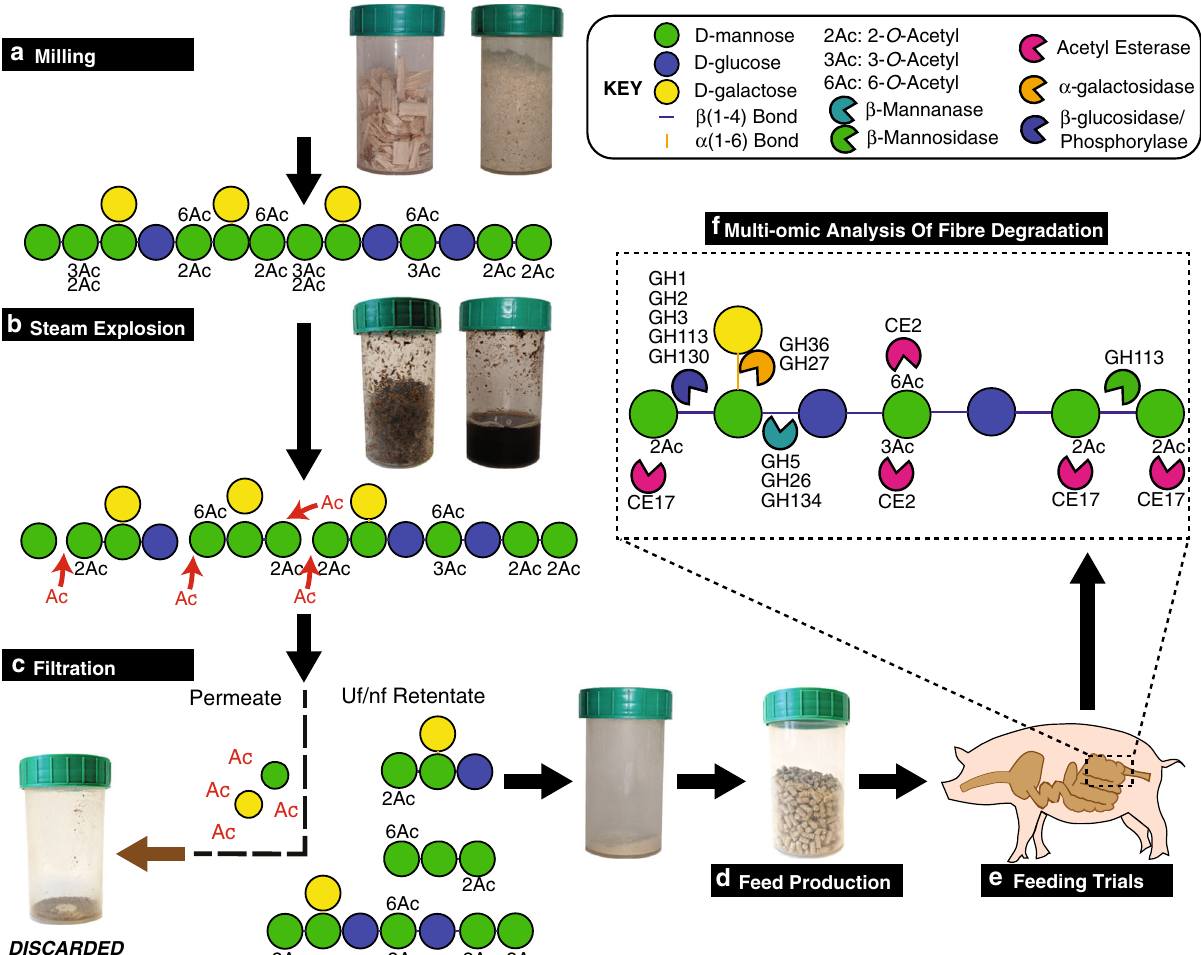
Fig. 1 Schematic representation and graphic illustration of the production pipeline for Norway spruce AcGGM. a Wood chips were milled to increase the surface area exposed for hydrothermal extraction and washing the released manno-oligosaccharides. Spruce wood contains long-chained galactoglucomannan (DP200-400), which is highly acetylated (DA ~ 0.65), predominantly with 2- O and 3- O acetylations 66 . b During hydrothermal pretreatment, the release of acetic acid promoted hydrolysis of glycosidic bonds, thereby relinquishing monosaccharides, oligosaccharides, and other breakdown products. c Ultra fi ltration retained the longer, complex oligosaccharides and discarded the monosaccharides, acetic acid, and other steam explosion byproducts. d The puri fi ed mannan was incorporated into feed pellets at varying inclusion levels, produced by a conventional feed pelleting process. e The growth performance experiment and a feeding trial were conducted in a randomized block design, with four inclusion levels of AcGGM. f Multi-omic approaches were used to analyze the porcine gut microbiome in response to AcGGM and determine if indigenous mannan PULs matched the glycan structure of the AcGGM fi ber. Glycosidic bonds between the β -(1,4)-mannose and glucose units in the backbone of AcGGM require hydrolysis by glycoside hydrolases (GH) from families GH5 and GH26. GH36 and GH27 α -galactosidases are required to remove the α -(1,6)-galactose decorations. Single mannose and glucose units are removed from the non-reducing end of the oligosaccharides by enzymes from families GH1, GH2, GH3, GH113, and GH130, while mannose in the reducing end can be removed by GH113 family mannosidases. 3- O - and 6- O -acetylations on mannan are removed by esterases from family CE2. A unique feature of particular beta-mannans is the axially oriented 2- O -acetylation on mannose, which is the prevalent form of acetylation present on AcGGM used in this study. 2- O -acetylations are removed by esterases homologous to the RiCE17 mannan-speci fi c esterase from Roseburia intestinalis , which was recently characterized by our group 5 We chose a dietary supplementation strategy, which is commonly applied to piglets during the post-weaning period to offset their particularly low feed intake and enhance gut health and growth performance 19 . Cautious measures were made to eliminate potential pen biases (see details in materials and methods), and fecal samples, as well as animal performance metrics, were taken before AcGGM administration (when piglets were assigned to pens), and subsequently at days 7, 14, 21 and 27 during the feeding trial. On day 28, the piglets were sacri fi ced and host gut tissue and digesta samples taken from all intestinal regions (duodenum, jejunum, ileum, cecum, and colon) for down-stream analysis (Supplementary Table 1 and Supplementary Data 1).